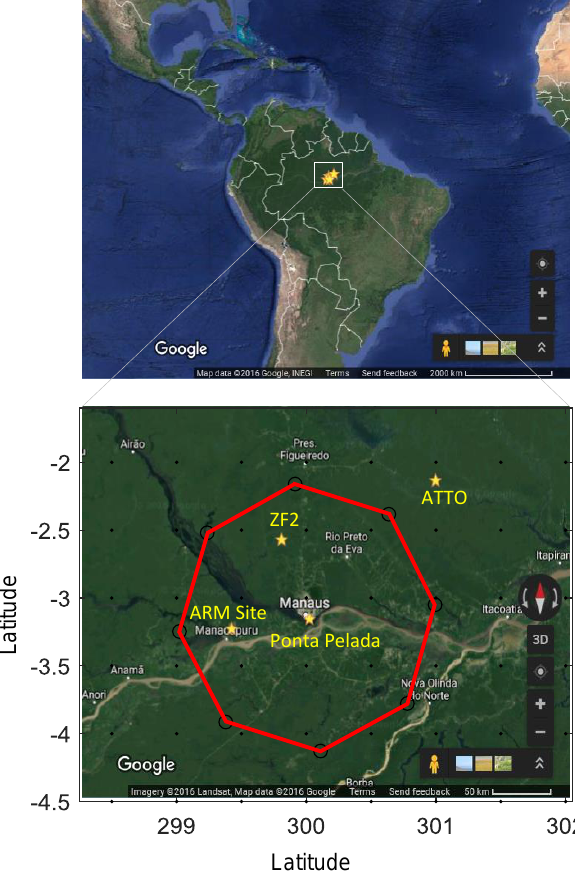
Figure 1. The location of GoAmazon site in this study. The red octagon represents the analysis domain. Locations of observational sites are indicated by yellow pentagrams. Locations of cities are indicated by white